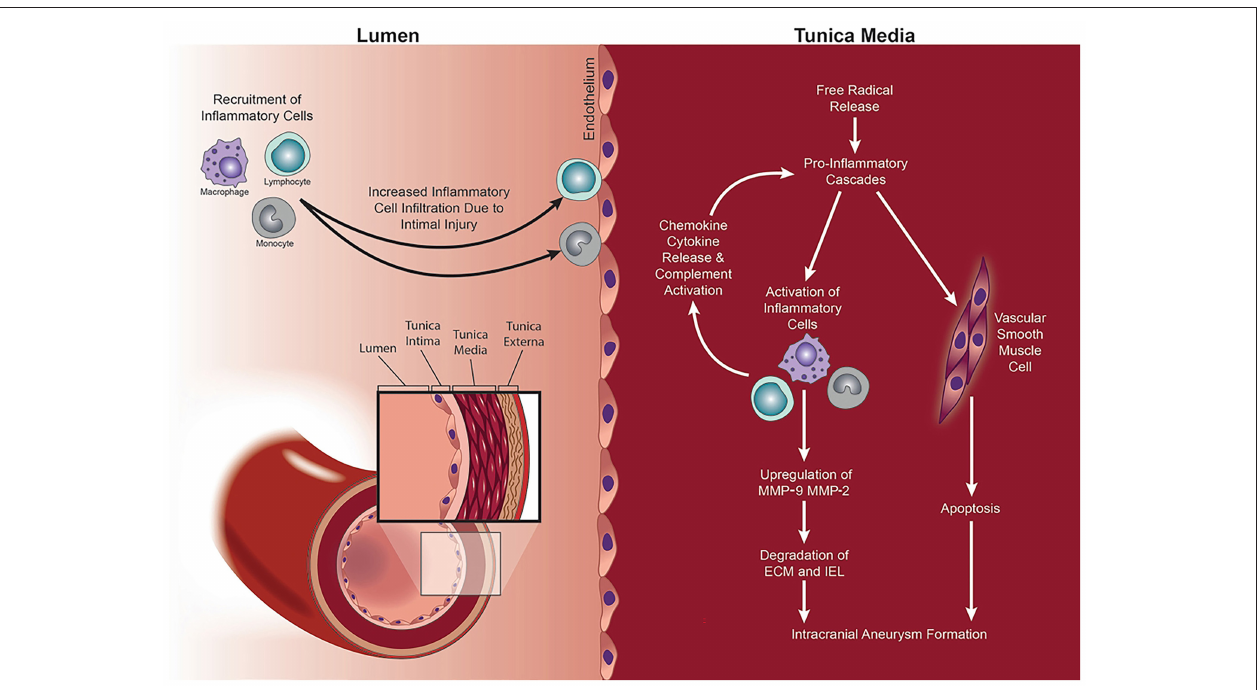
FIGURE 10 | MMPs mediate IA formation via a process of vascular remodeling. Intimal injury and increased wall shear stress (WSS) lead to the recruitment and infiltration of inflammatory cells into the vessel wall. Release of free radicals, pro-inflammatory chemokines and cytokines, and activation of the complement cascade mediate the upregulation of MMP-2 and MMP-9. The consequent proteolytic process results in the degradation of the ECM within the tunica media and altered the structure of the vessel wall with IA formation. Copyright Department of Neurosurgery, The University of Utah. Published with permission (44).